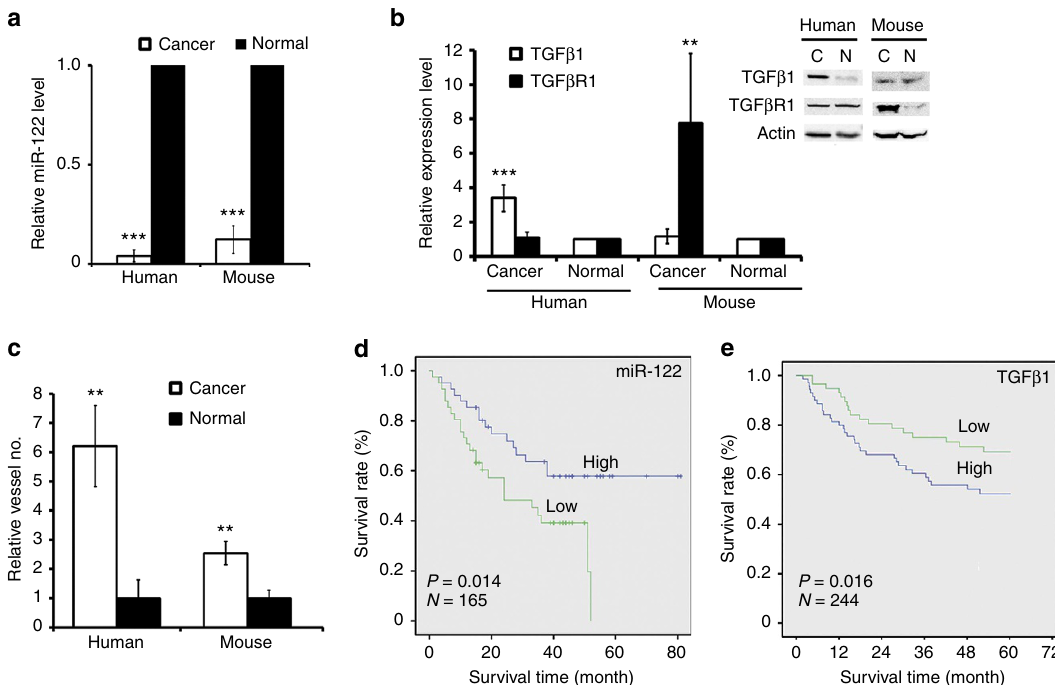
Figure 6 | Loss of miR-122 resulted in the different metastatic effects in humans or mice liver cancers in vivo . ( a ) Quantitative analysis of miR-122 levels in hepatocellular tumours in HBx gene knock-in transgenic mice or normal liver tissue (eight independent repeats) as well as human hepatocellular tumour tissues or normal adjacent tissue (six independent repeats). ( b ) Western blot assay showing the expression levels of TGF b 1/TGF b R1 in tissues, as indicated. Representative images are shown in the inset. Eleven independent repeats are performed in each experiment. ( c ) Quantitative analysis of vessel numbers in the indicated tissues by CD31 staining. ( d ) Kaplan–Meier curves for overall survival in HCC cohorts from the Liver Cancer Institute (LCI) and Zhongshan Hospital. Expression value ¼ log2 of Robust multi-array analysis (RMA)-calculated signal intensity. miR-122 expression value 4 0.39 was designed as the high expression group, while miR-122 expression value o -0.58 was designed as the low expression group. n ¼ 165 patients; P value based on the Mantel–Cox log-rank test. ( e ) Kaplan–Meier curves for overall survival in HCC cohorts from the LCI and Zhongshan Hospital. Expression value ¼ log2 of RMA-calculated signal intensity. TGF b 1 expression value o 4 was designed as the low expression group, while TGF b 1 expression value 4